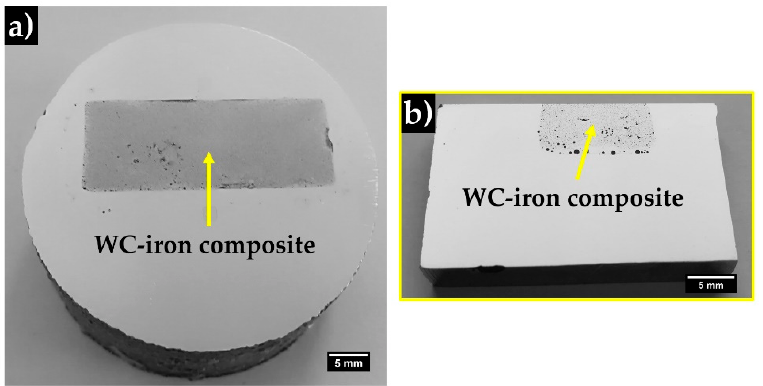
Figure 12. The reinforced cast specimen ( a ) and a cross-section ( b ) to highlight the depth of the composite and the interface zone.